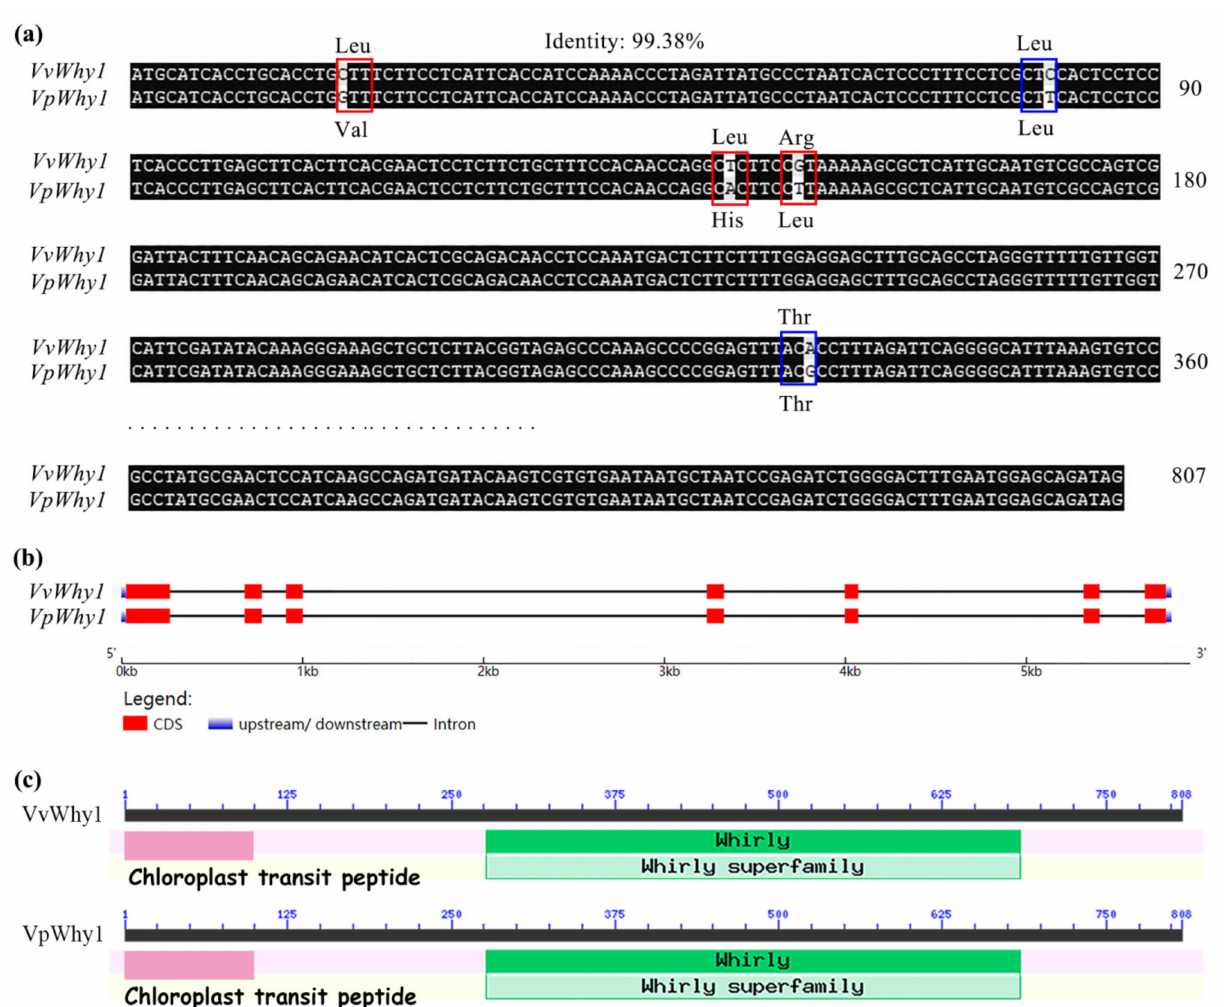
Figure 1. Sequence alignment, gene structure and conserved domain of VvWhy1 and VpWhy1 . ( a ) Sequence alignment of VvWhy1 and VpWhy1 shows an identity of 99.38% with five different nucleotides encoding three different amino acid residues. The red frame shows the encoding of different amino acids, and the blue frame shows the encoding of the same amino acids. ( b ) Gene structure of VvWhy1 and VpWhy1 , which consisted of seven exons and six introns. ( c ) Conserved domain of VvWhy1 and VpWhy1 reveals C-terminal Whirly conserved domain and N-terminal chloroplast transit